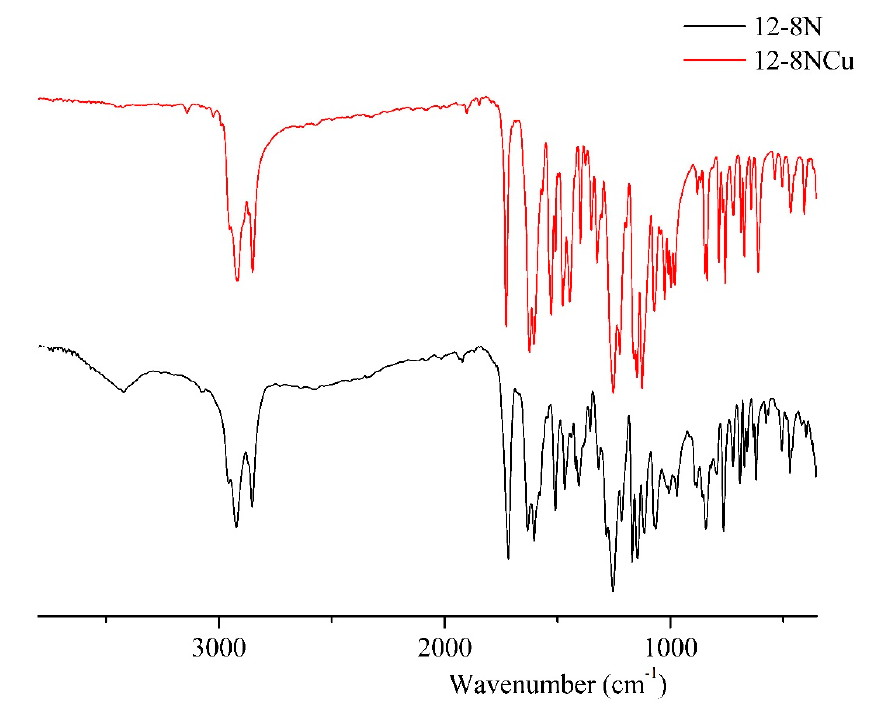
Figure 1. FTIR curves of 12-8N (black) and 12-8NCu (red). The 1 H-NMR of A11O-6ON and of its palladium complex are reported in Figure 2 as an example. The shift of the proton of imine, from 3.68 ppm in the free ligand to 4.11 ppm of the Pd compound is evidence of the complex formation. Analogue’s behavior is observable in 1H NMR of A11O-6ONNi where the proton of imine shifts from 3.68 ppm in the free ligand to 4.03 ppm (Figure S3). In Table S1, the most relevant 1H NMR data are reported.